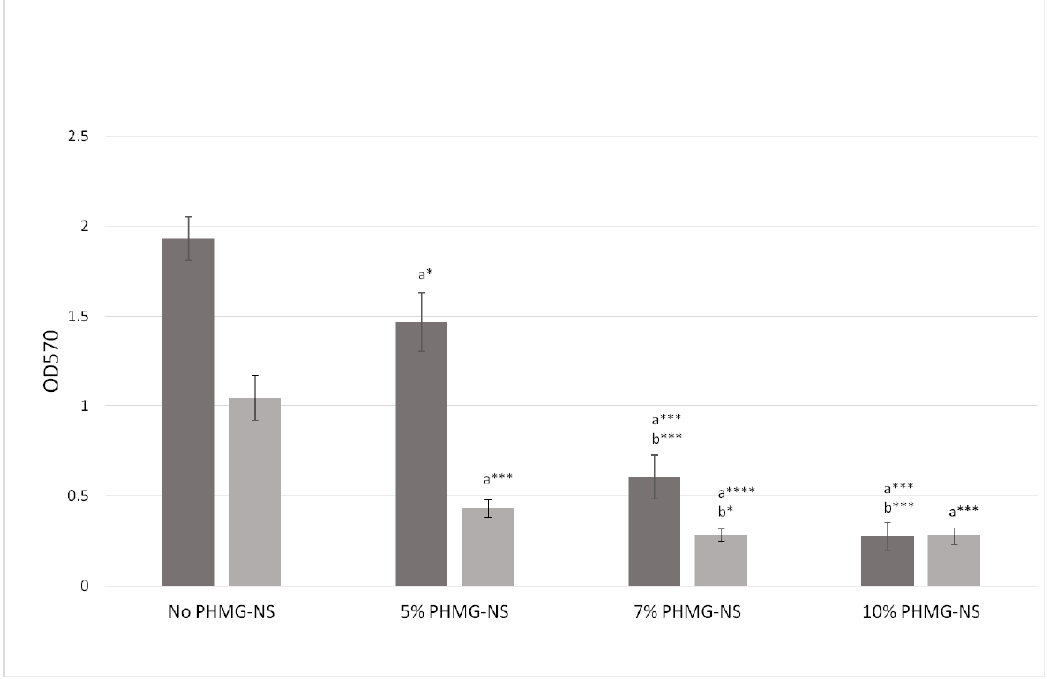
Figure 3. The level of biomass of E. coli K12 (dark grey) and S. aureus ATCC 25923 (light